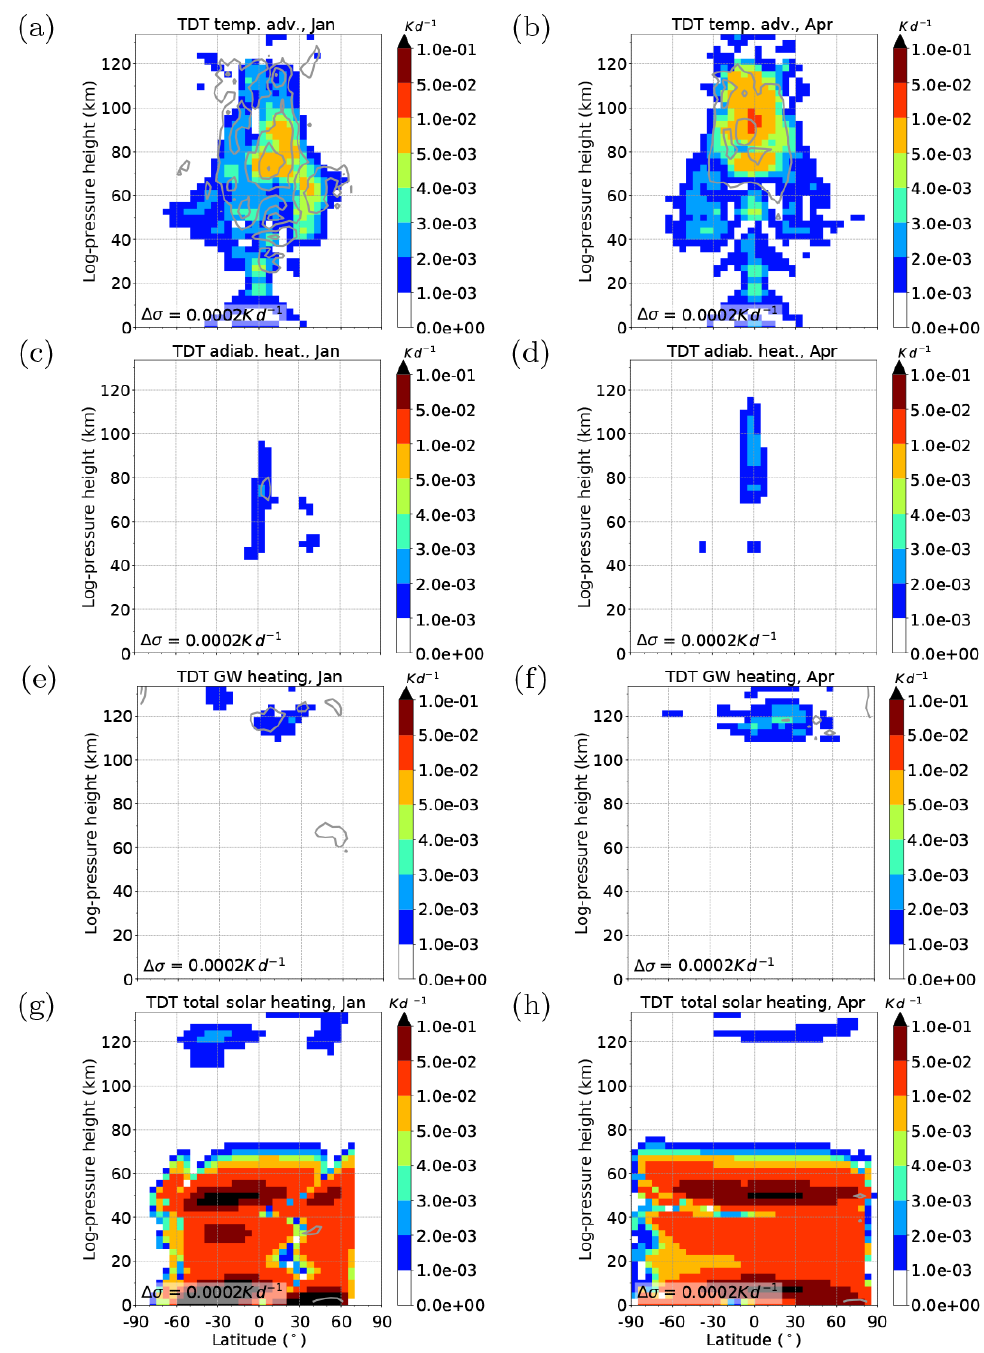
Figure 2. Terdiurnal component of thermal tendency terms in the REF simulation for January conditions (a, c, e, g) and April conditions (b, d, f, h) . Amplitudes are scaled by exp {− z( 2 H) − 1 } . Results are an average of the 11 ensemble members (color shading). Standard deviations ( σ ) are added as gray contour lines. (a, b) Temperature advection (nonlinear component of Eq. 4), (c, d) adiabatic heating (nonlinear component of Eq. 5), (e, f) heating due to gravity wave activity (tendency term from gravity wave parameterization), and (g, h) solar heating (tendency term from solar radiation parameterization). Note that the color scale is not